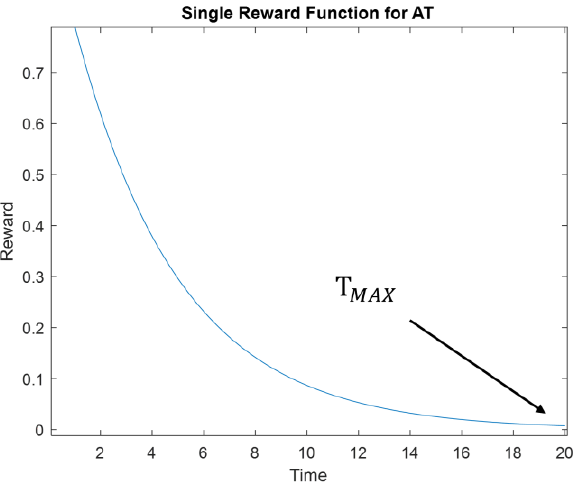
Figure 12. Reward function for taxi dispatcher.